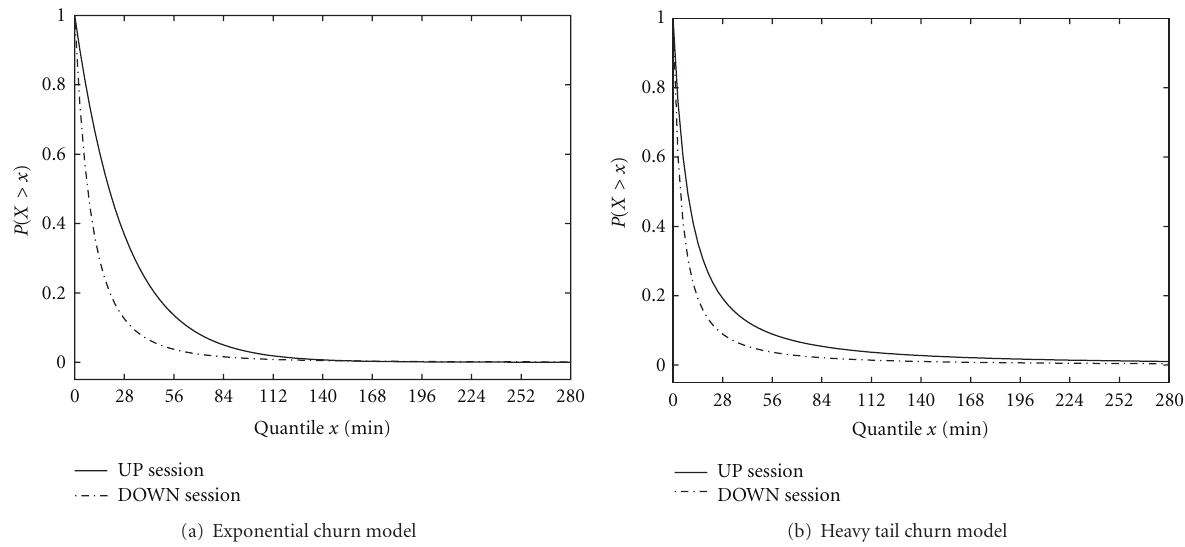
Figure 4: Complementary cumulative distribution functions of UP and DOWN session duration used on exponential and heavy tail churn